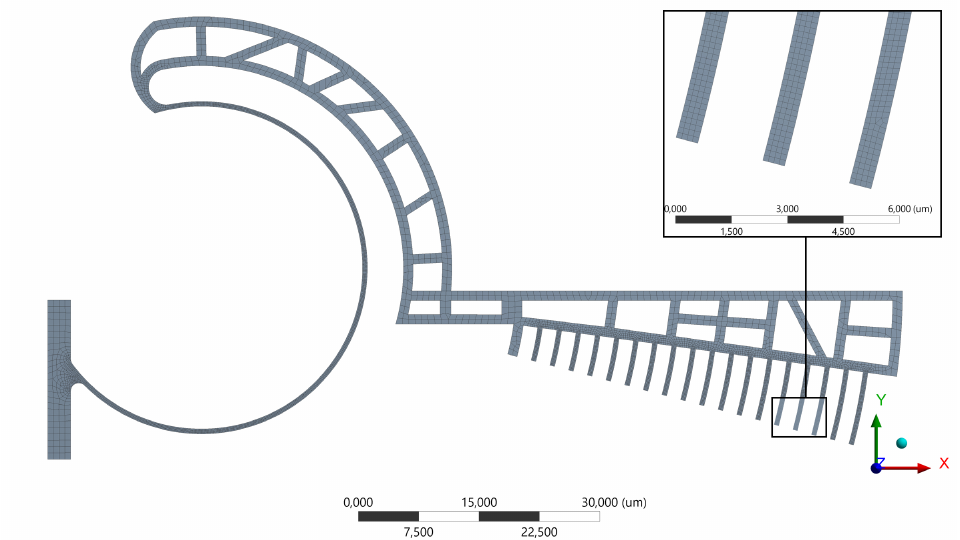
Figure 3. First layout: mesh of the floating structure and detail of the comb-drive fingers.